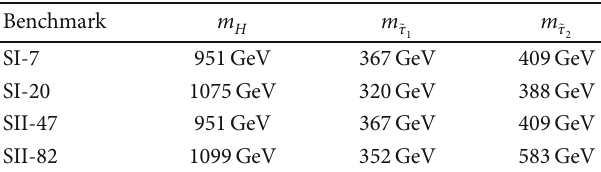
Table 5: List of the relevant parameters of the four benchmarks used for the comparison between Scenarios I and